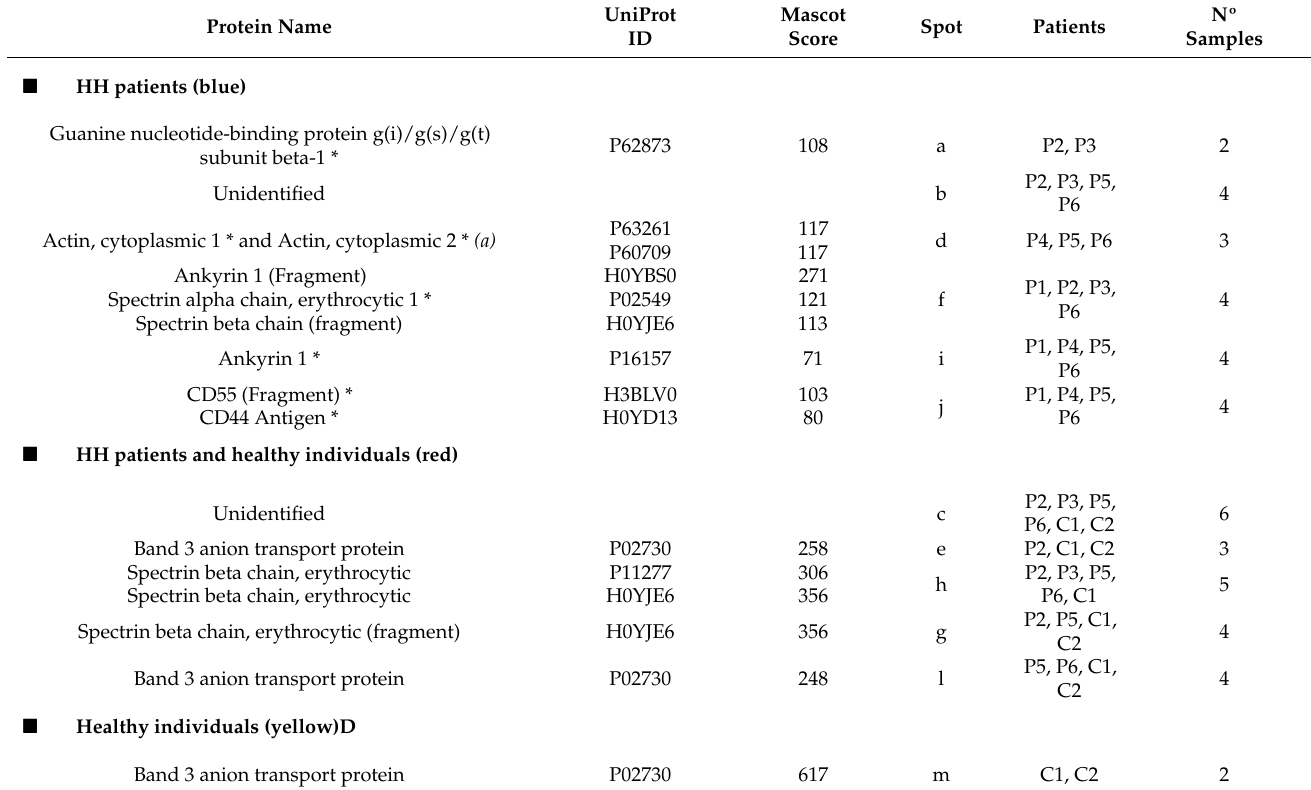
Table 1. HNE-modified membrane proteins from erythrocytes of HH